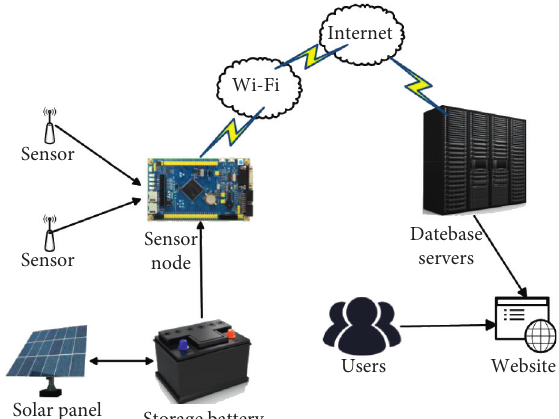
Figure 1: Overview of the system design.